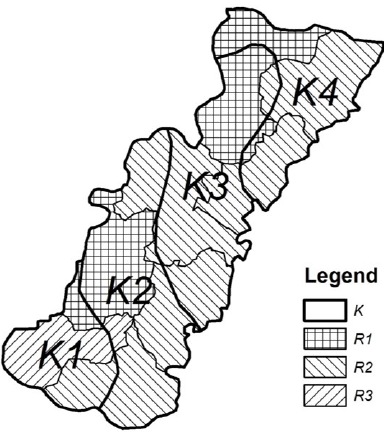
Figure 3. Zonation of hydraulic conductivities and recharge infil- tration